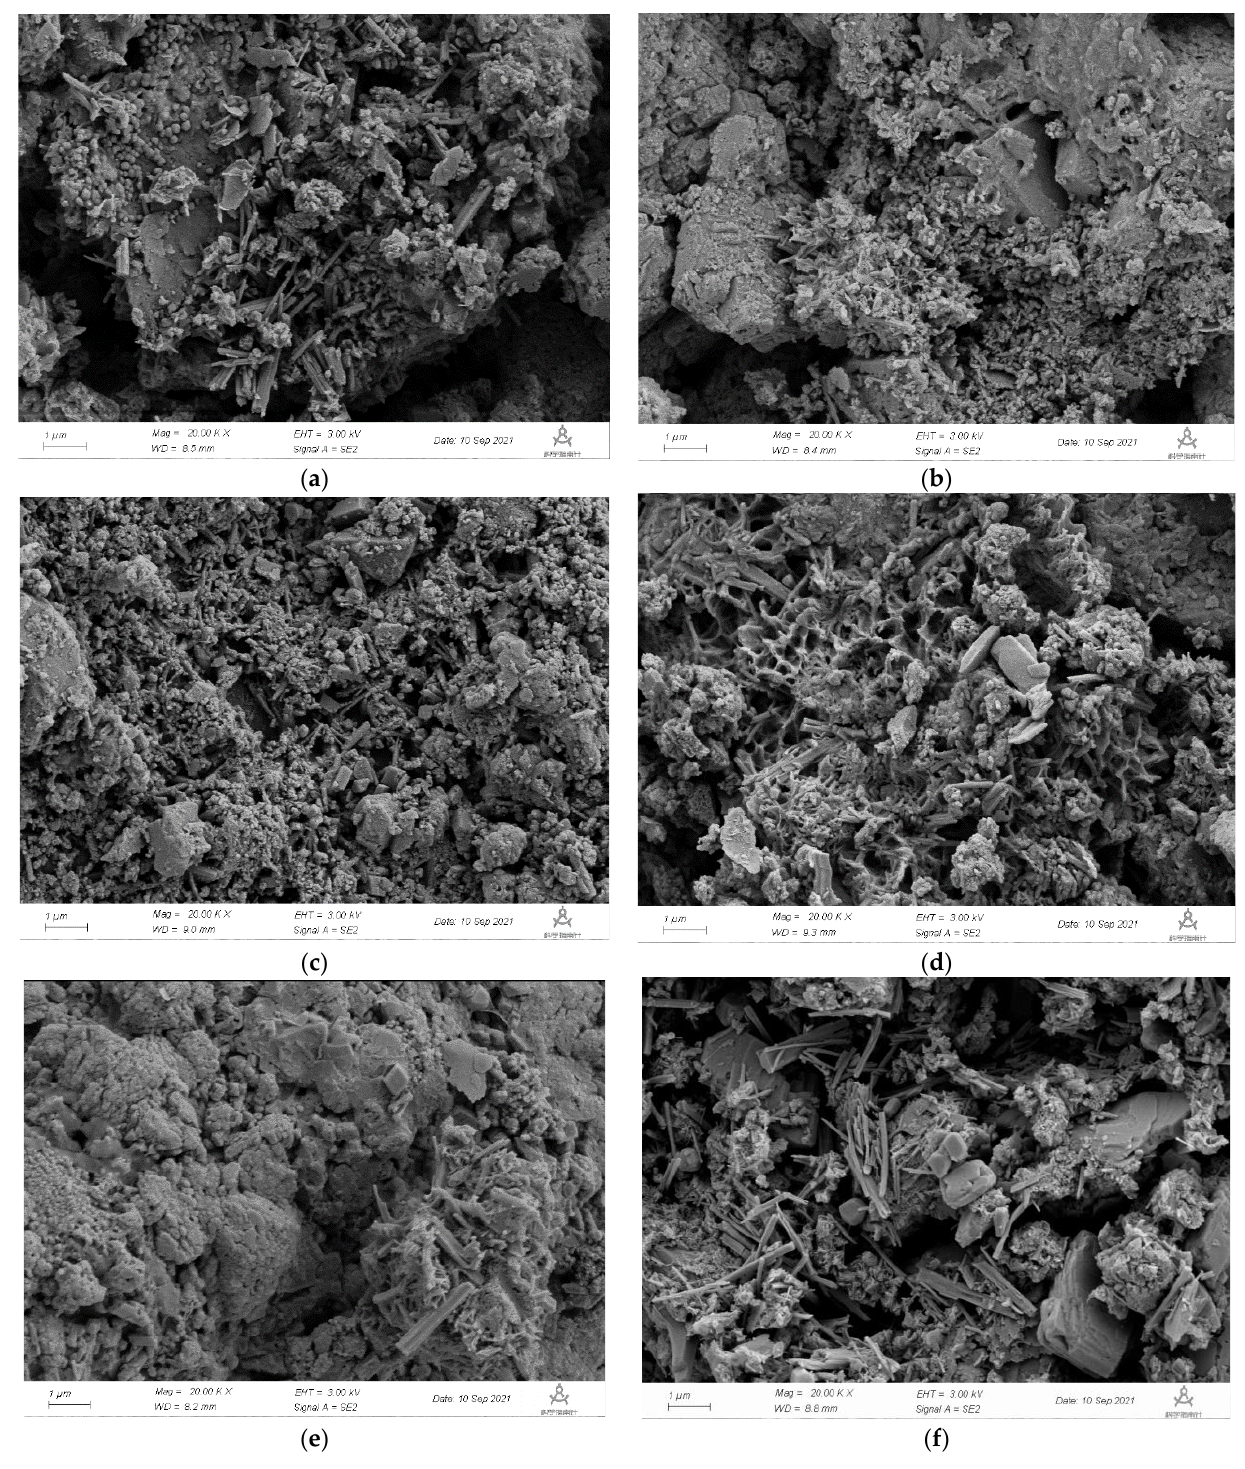
Figure 8. Microstructure of composite cementitious material at 28 days: ( a ) 0% phosphogypsum; ( b ) 10% phosphogypsum; ( c ) 30% phosphogypsum; ( d ) 50% phosphogypsum; ( e ) 70% phosphogyp- sum; ( f ) 90%